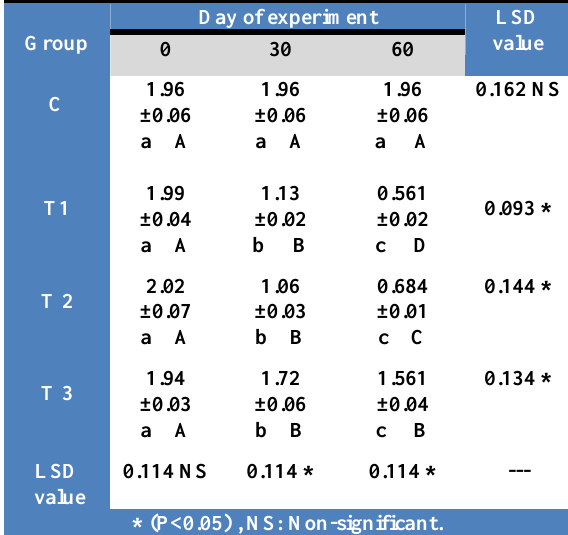
Table, 1: The effect of oral intubation for two months with sodium molybdate, sodium sulfate and their combination on serum copper level (mg/dL) of adult male rats. Group